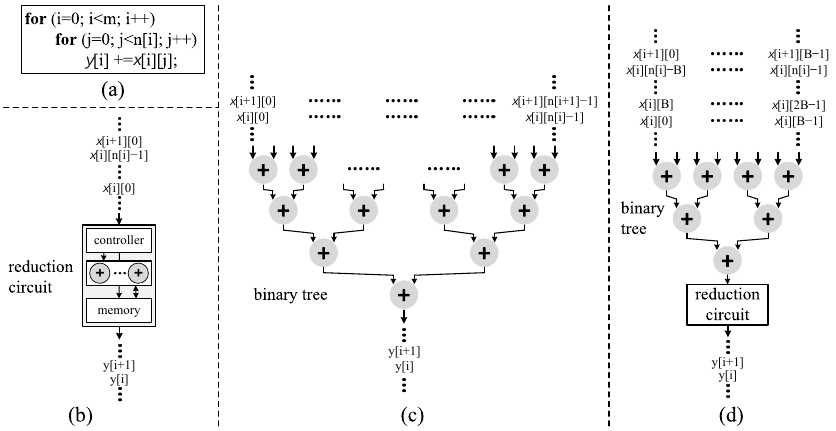
Figure 1. Reduction of multiple data sets: different solutions. ( a ) computing tasks; ( b ) reduction circuit; ( c ) binary tree; ( d ) a compromise solution: reduction circuit + binary